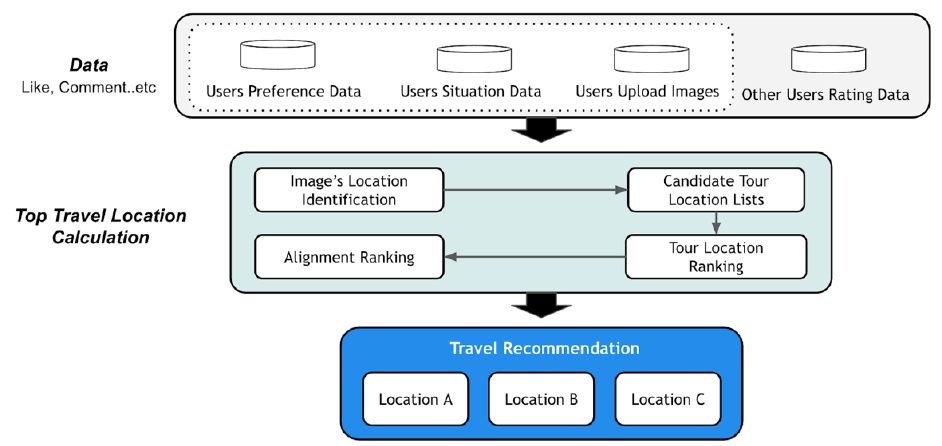
Figure 18. Structural diagram of a tourism recommendation system for providing popular landmarks and optimal routes.